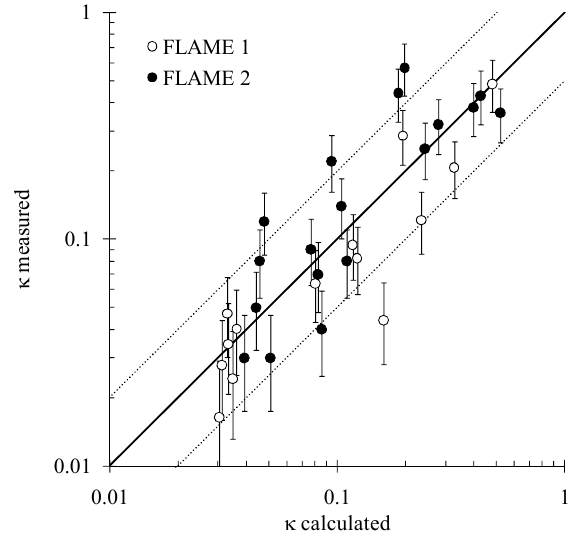
Fig. 8. Comparison of HTDMA-derived ensemble κ with κ values calculated from PM 2 . 5 chemical composition from IMPROVE filter Figure 8. Comparison of HTDMA-derived ensemble κ with κ values calculated from PM 2.5 4 samples for FLAME1 and 2 chamber burns. The solid line is 1:1 chemical composition from IMPROVE filter samples for FLAME1 and 2 chamber burns. The 5 and the dashed lines represent ± a factor of solid line is 1:1 and the dashed lines represent ± a factor of 2. 6